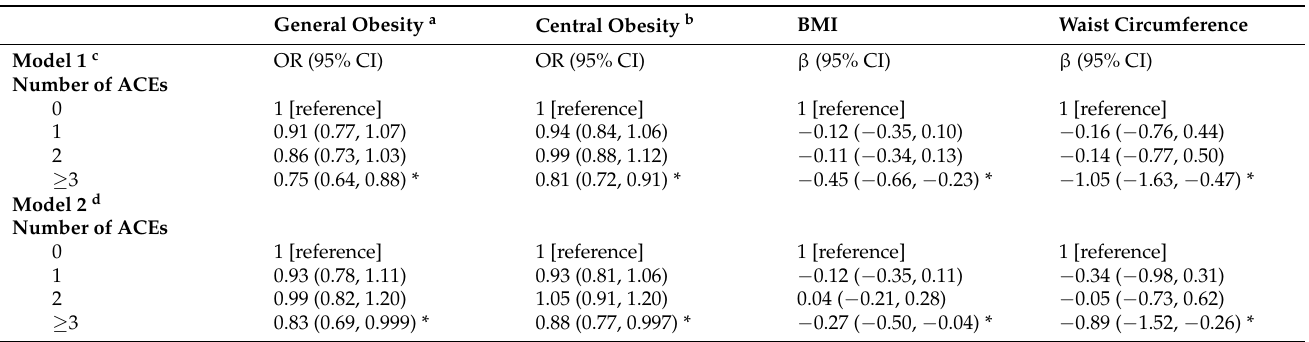
Table 2. Associations between the number of ACEs and general obesity, central obesity, BMI, and waist circumference.